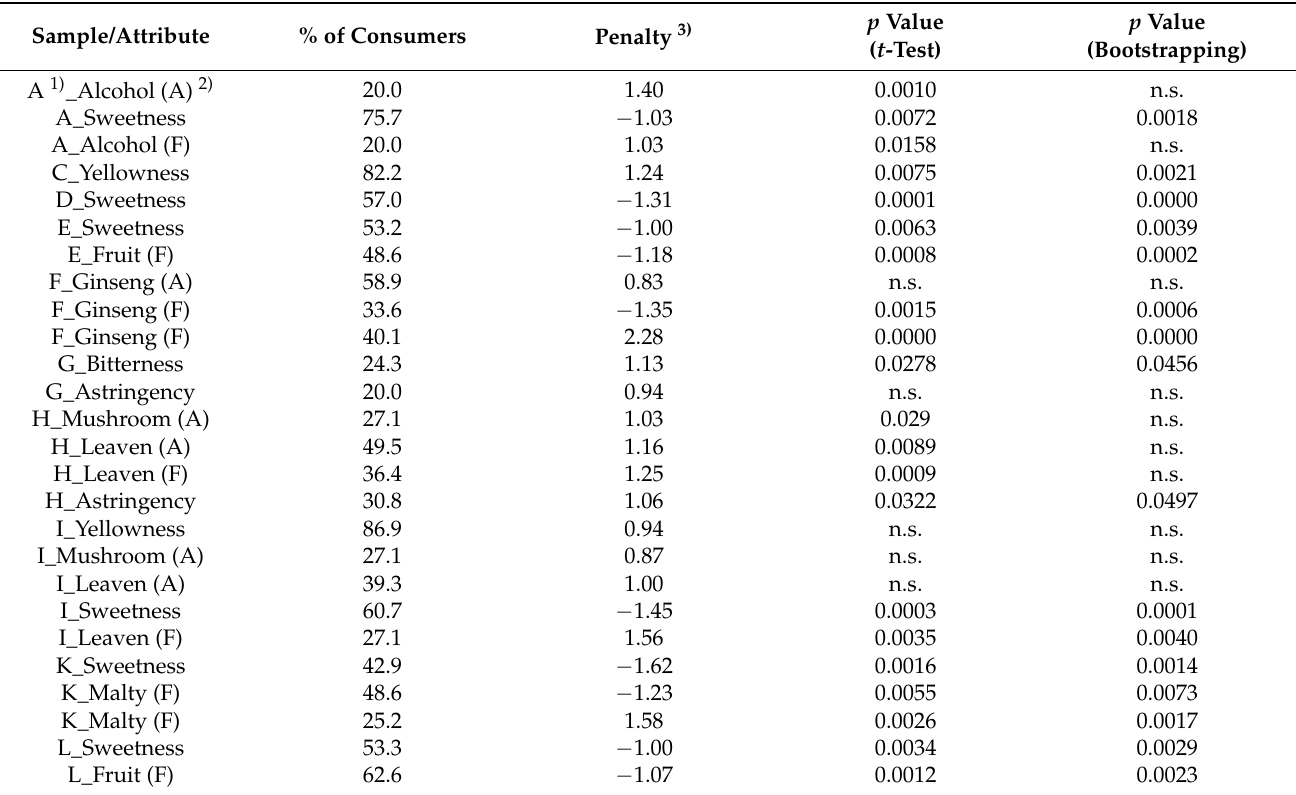
Table 4. Summary of penalty analysis obtained from the CATA-JAR